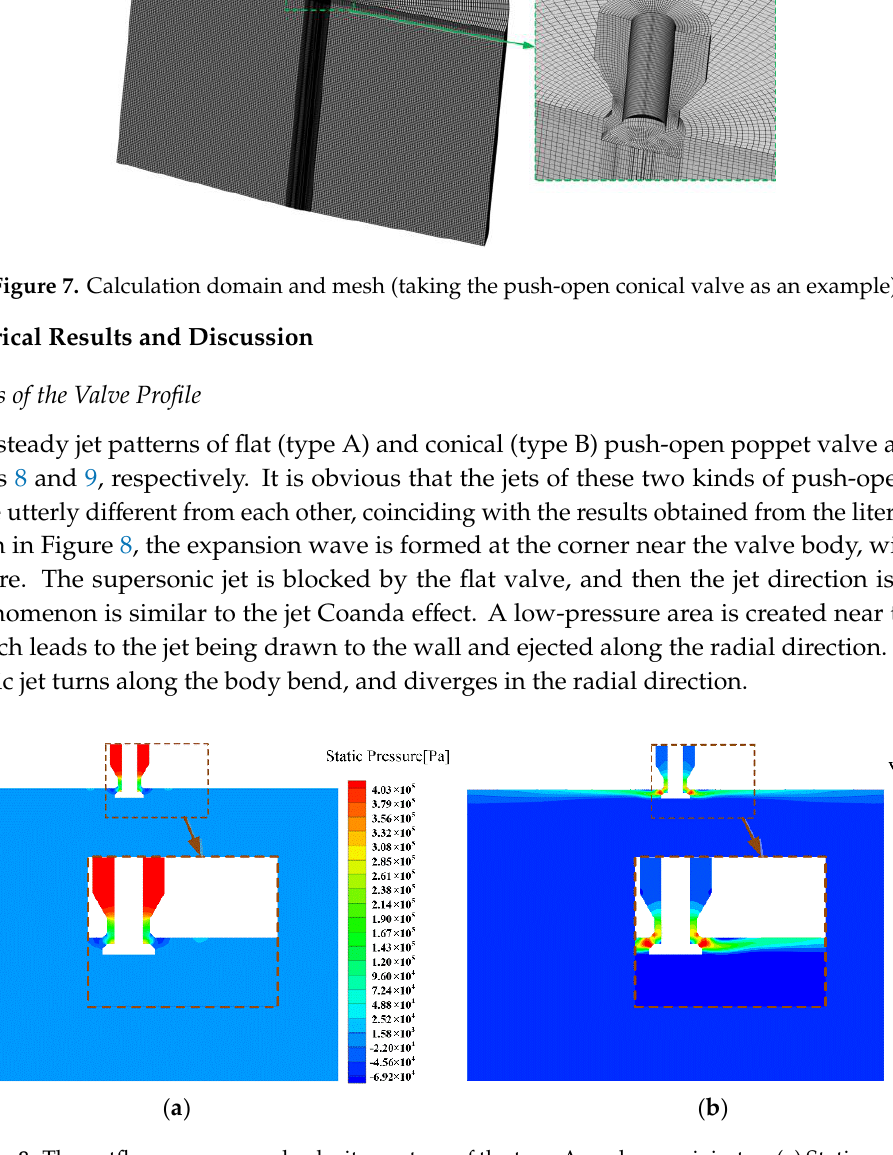
Figure 8. The outflow pressure and velocity contour of the type A push-open injector. ( a ) Static pressure contour; ( b ) Velocity contour (inlet pressure, 4 bar).